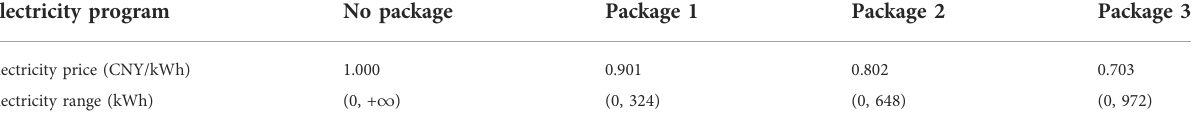
TABLE 3 Settings of each package